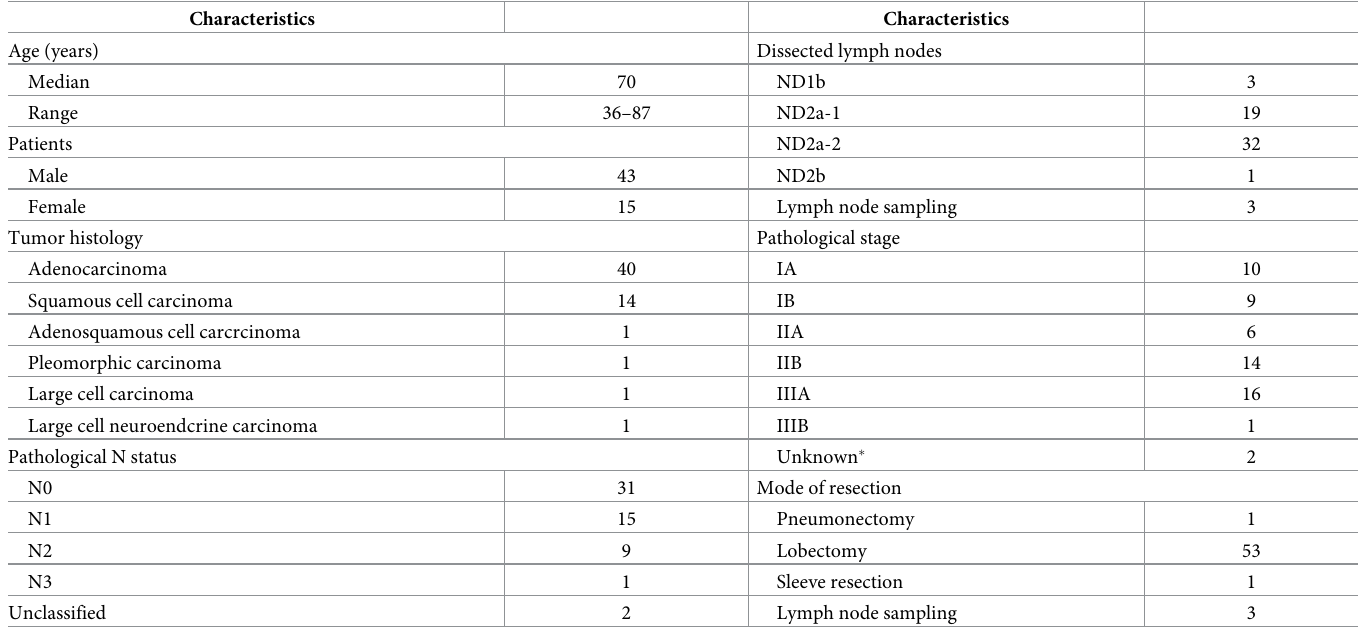
Table 2. Patients’